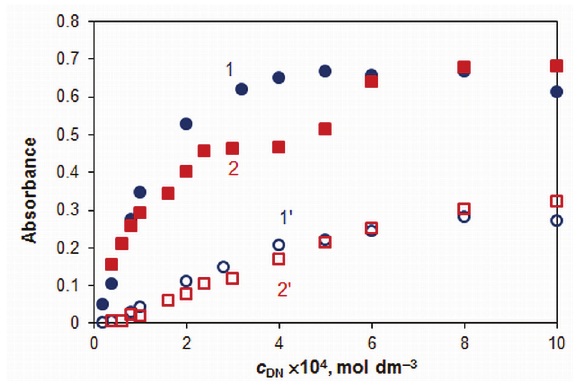
Figure 2: Absorbance of extracted species vs concentration of ND. pH 5.5, c = c = 3×10 −5 mol dm −3 , c = 1.0×10 −3 mol dm −3 , λ = V(IV) V(V) TTC 333 nm (1 and 2) or 630 nm (1’ and 2’). 1 and 1’ obtained with V IV , and 2 and 2’ – with V V